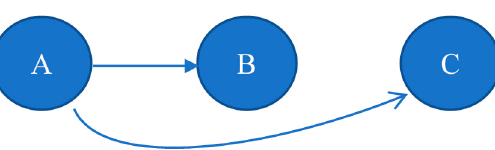
Figure 2. Illustration of relevant interconnections to first- and second-degree neighbors for grid model planning.